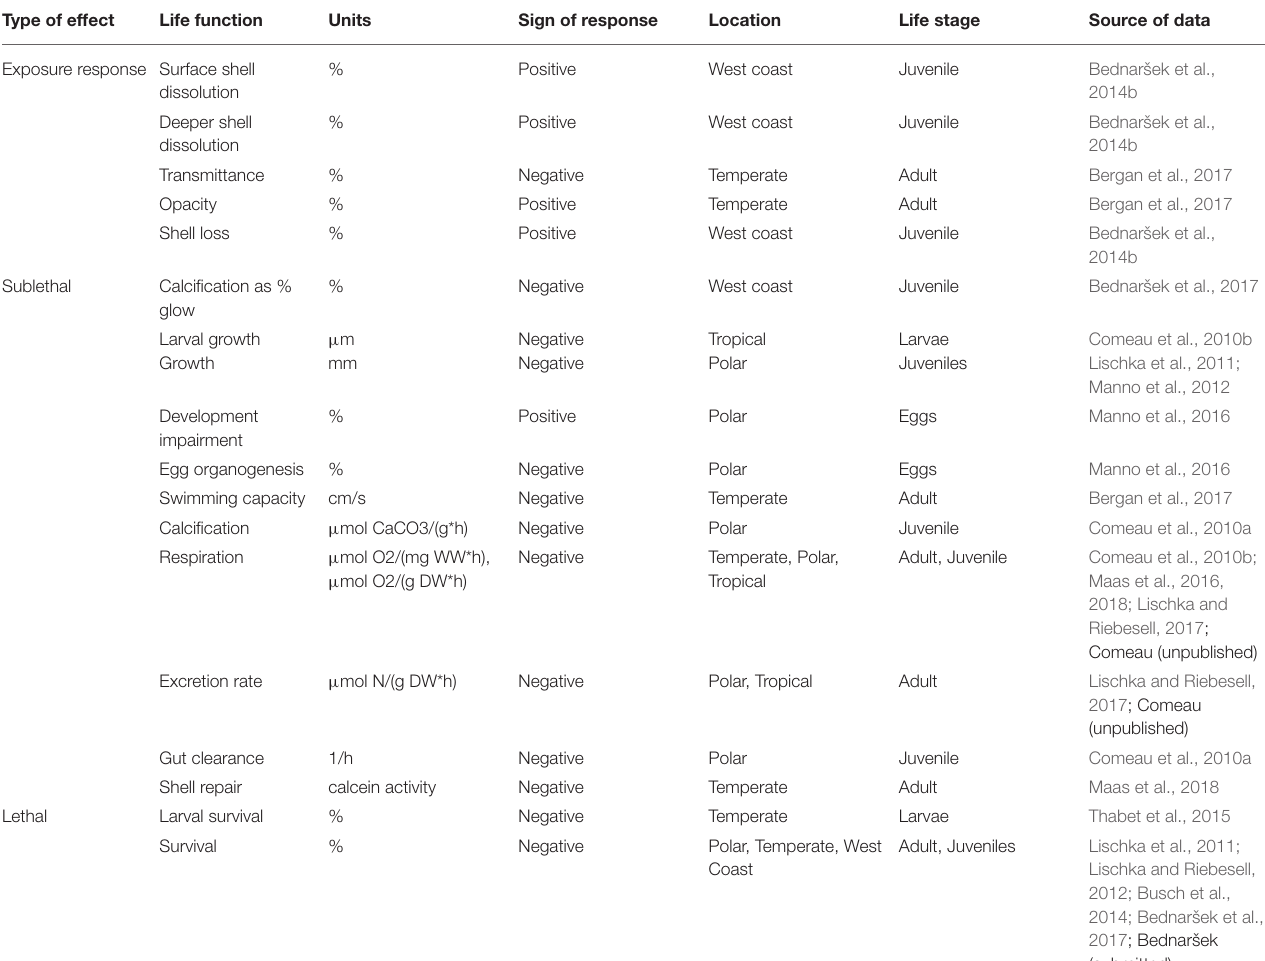
TABLE 1 | Responses considered for threshold